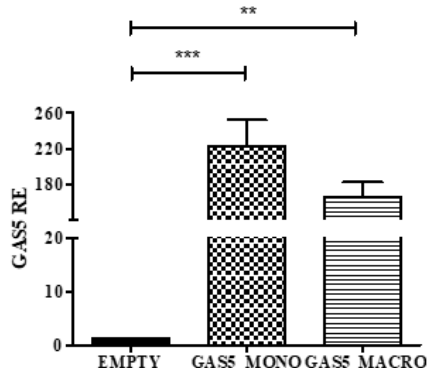
Figure 6. Evaluation of GAS5 levels after transfection with pcDNA- GAS5 plasmid in monocytes ( GAS5 _MONO) and macrophages ( GAS5 _MACRO). GAS5 expression was normalized using GAPDH gene and relative expression (RE) values are expressed as 2 − ∆ Ct . One-way ANOVA GAS5 p = 0.0005, Bonferroni’s multiple comparison post-test ** p < 0.01, *** p <